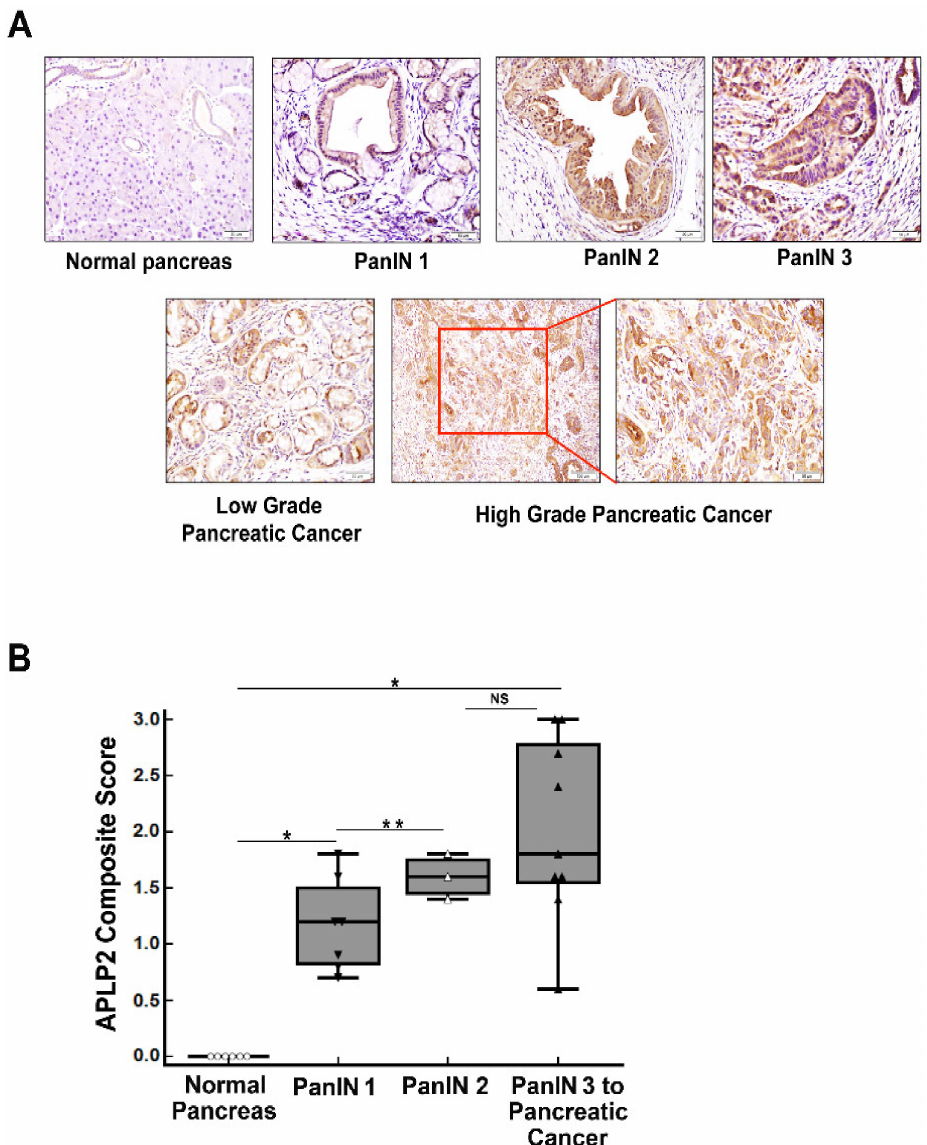
Figure 2. APLP2 increases with progression to pancreatic adenocarcinoma in a mouse model. Immunohistochemistry was used to analyze the expression of APLP2 in tissue samples from 20-week-old KPC mice. ( A ) APLP2 staining was absent in normal pancreas tissues. PanIN 1, 2, and 3 displayed weak to strong staining of APLP2 in the cytoplasm. Both low- and high-grade pancreatic cancer samples with intensely positive cytoplasmic APLP2 staining >80% are shown. A scale bar is displayed in the lower right corner of each section. For all sections except the bottom middle one, the scale bar represents 50 µ m. For the bottom middle section, the scale bar represents 100 µ m. ( B ) The expression of murine APLP2 in normal and pancreatic tissue is graphically represented in a box plot, which shows the immunohistochemistry data based on H-scores. These scores indicate a statistically significant increase in APLP2 expression in murine PanIN 1 (* p < 0.05) compared to the normal murine pancreas and in PanIN 2 compared to PanIN 1 (** p < 0.01). APLP2 expression was significantly greater in PanIN 3/pancreatic cancer relative to the normal pancreas (* p < 0.05). NS = Not Significant. The staining was scored according to intensity on a 0–3 scale (0 = negative, 1 = weak, 2 = moderate, 3 = strong). The percentage of cells stained for murine APLP2 was evaluated based on the absolute stain (i.e., 10–100% is scored as 0.1 to 1). The Histo-score (H-score) was calculated by multiplying the staining intensity by the percentage of cells positive for APLP2 expression. Statistical analysis was performed using the Student’s t